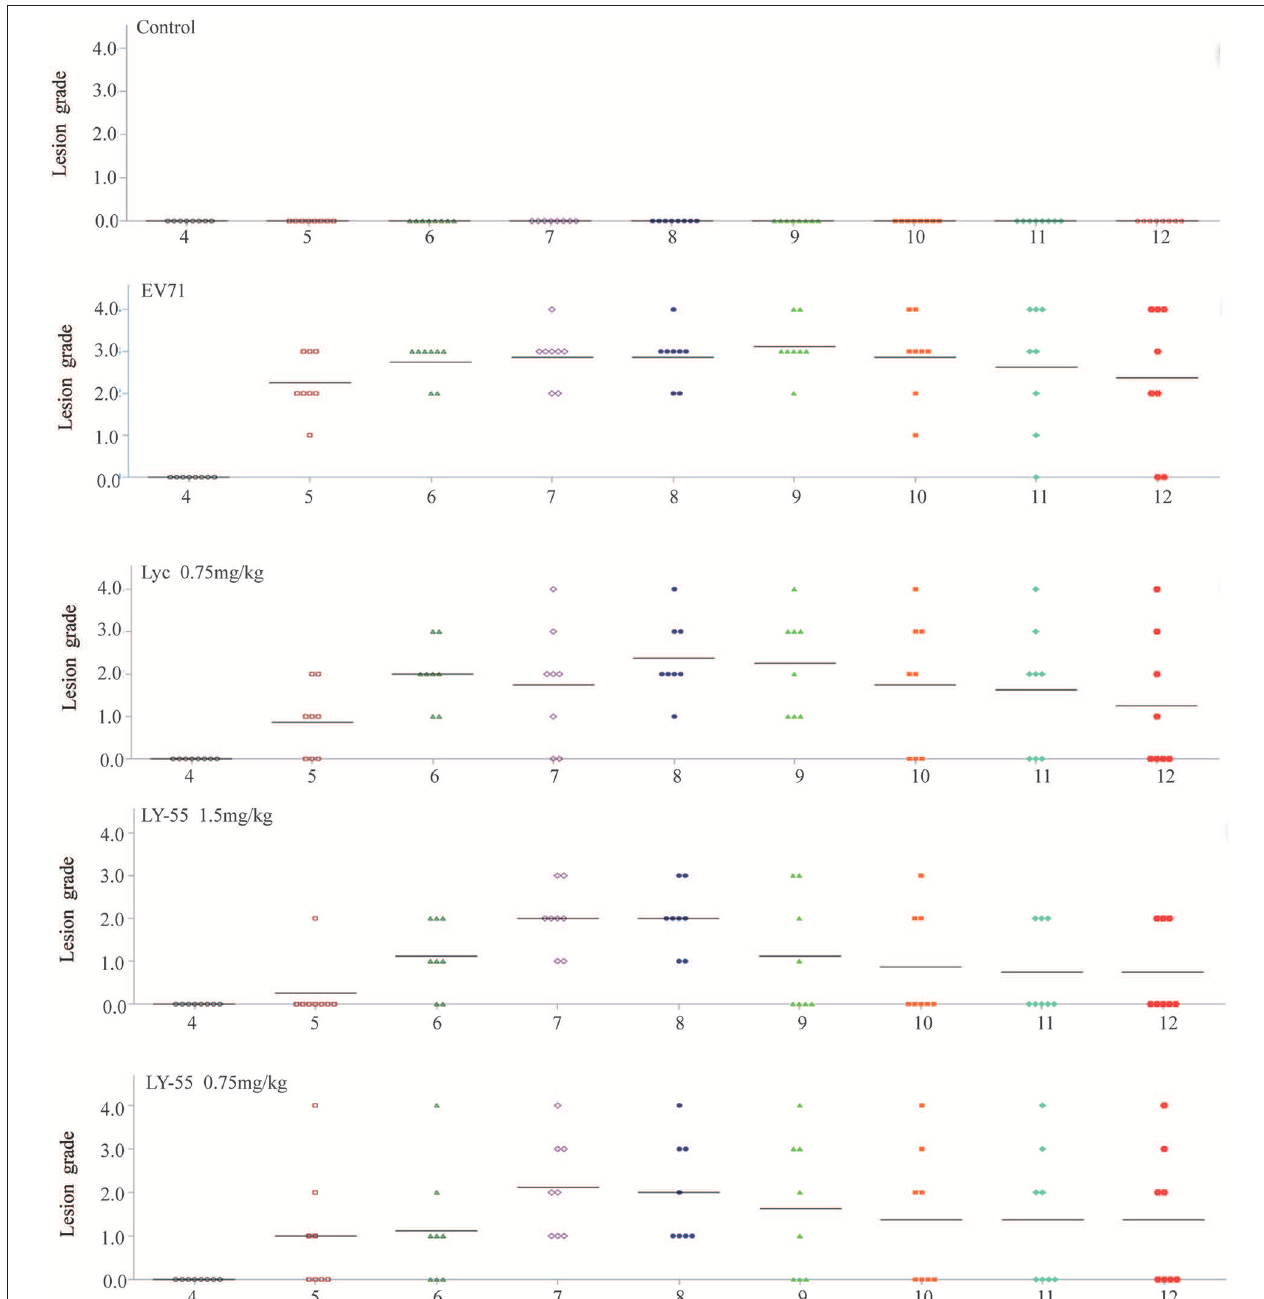
FIGURE 6 | LY-55 treatment protected mice from apparent symptoms post sub-lethal dose EV71 challenge. 12-day ICR mice were infected with 1 LD 50 of EV71-mouse adapted strain (EV71-H-MA), followed by daily administration of LY-55 and lycorine at the indicated doses. Eight mice enrolled in each group were intraperitoneally injected with LY-55 or lycorine for 7 consecutive days and observed for morbidity daily for 12 days.